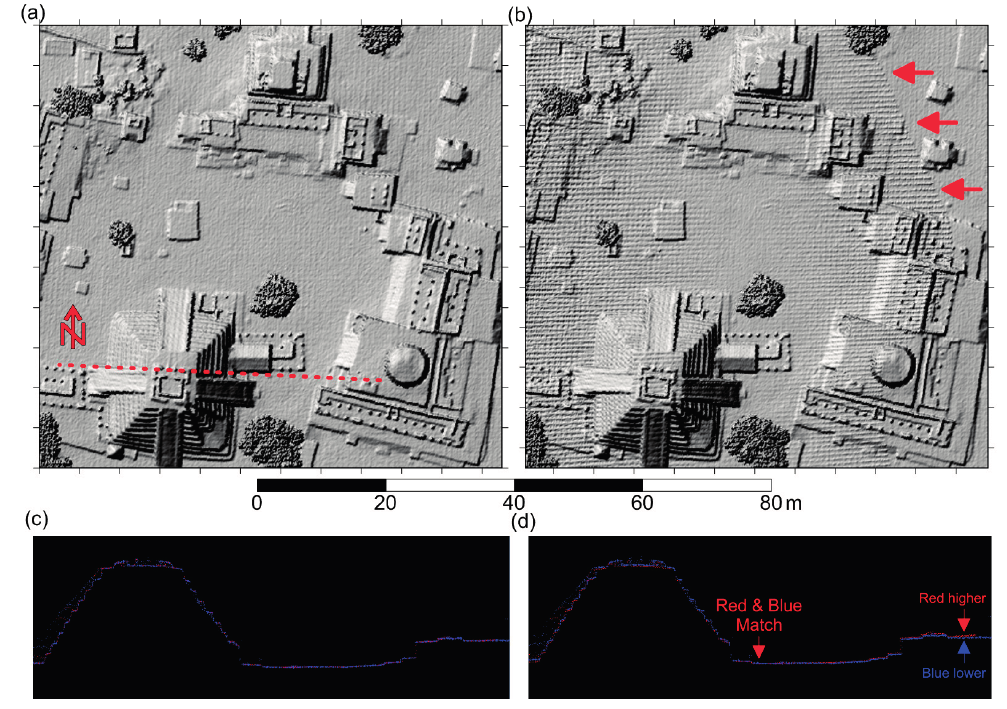
Figure 16. Sensor calibration ( a ) DSM from a properly calibrated dataset, the red dashed line represents the location of the cross sections; ( b ) DSM from simulated bad calibrated dataset; ( c ) Cross section from the properly calibrated dataset; ( d ) Cross section from the improperly calibrated